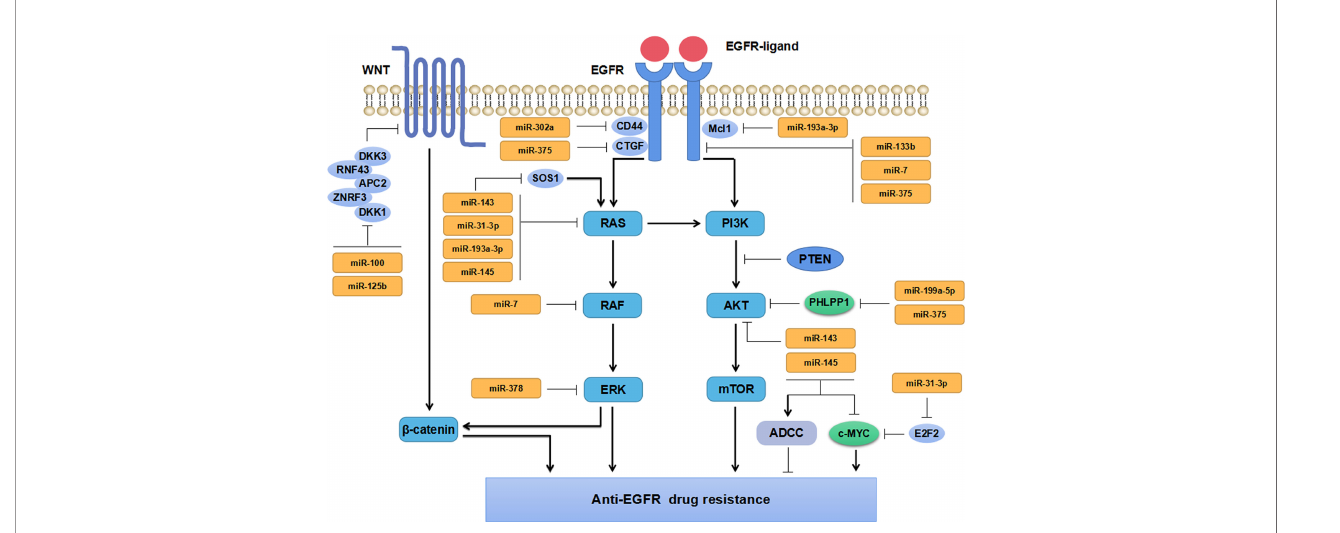
FIGURE 2 | Mechanisms of miRNAs regulating anti-EGFR drug resistance in